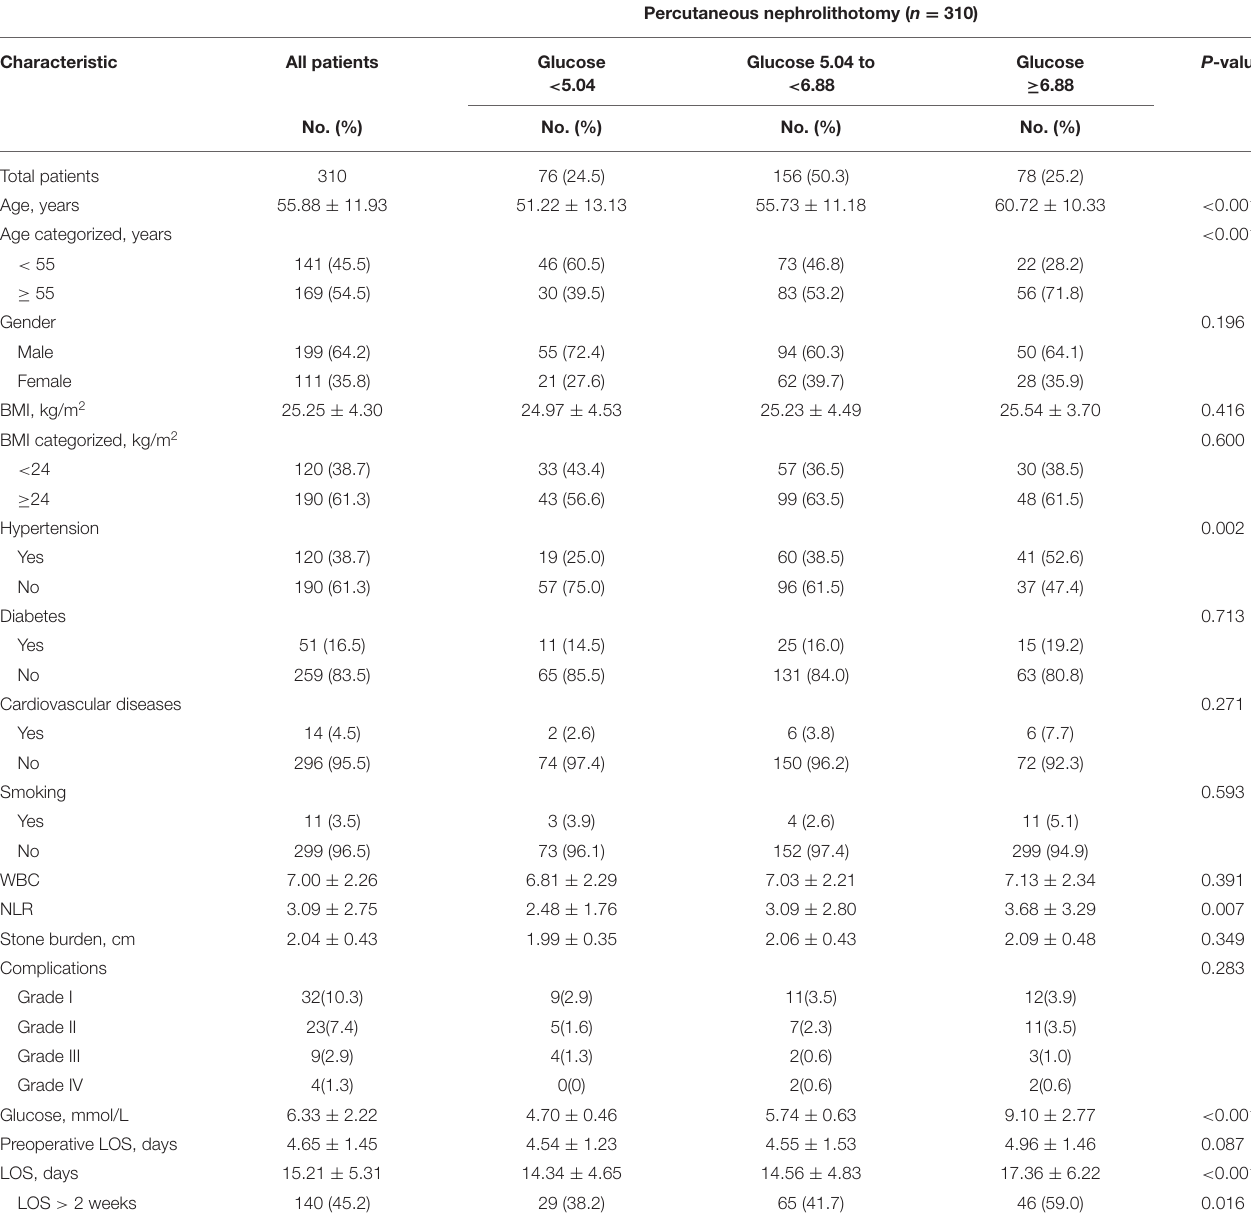
Percutaneous nephrolithotomy ( n =